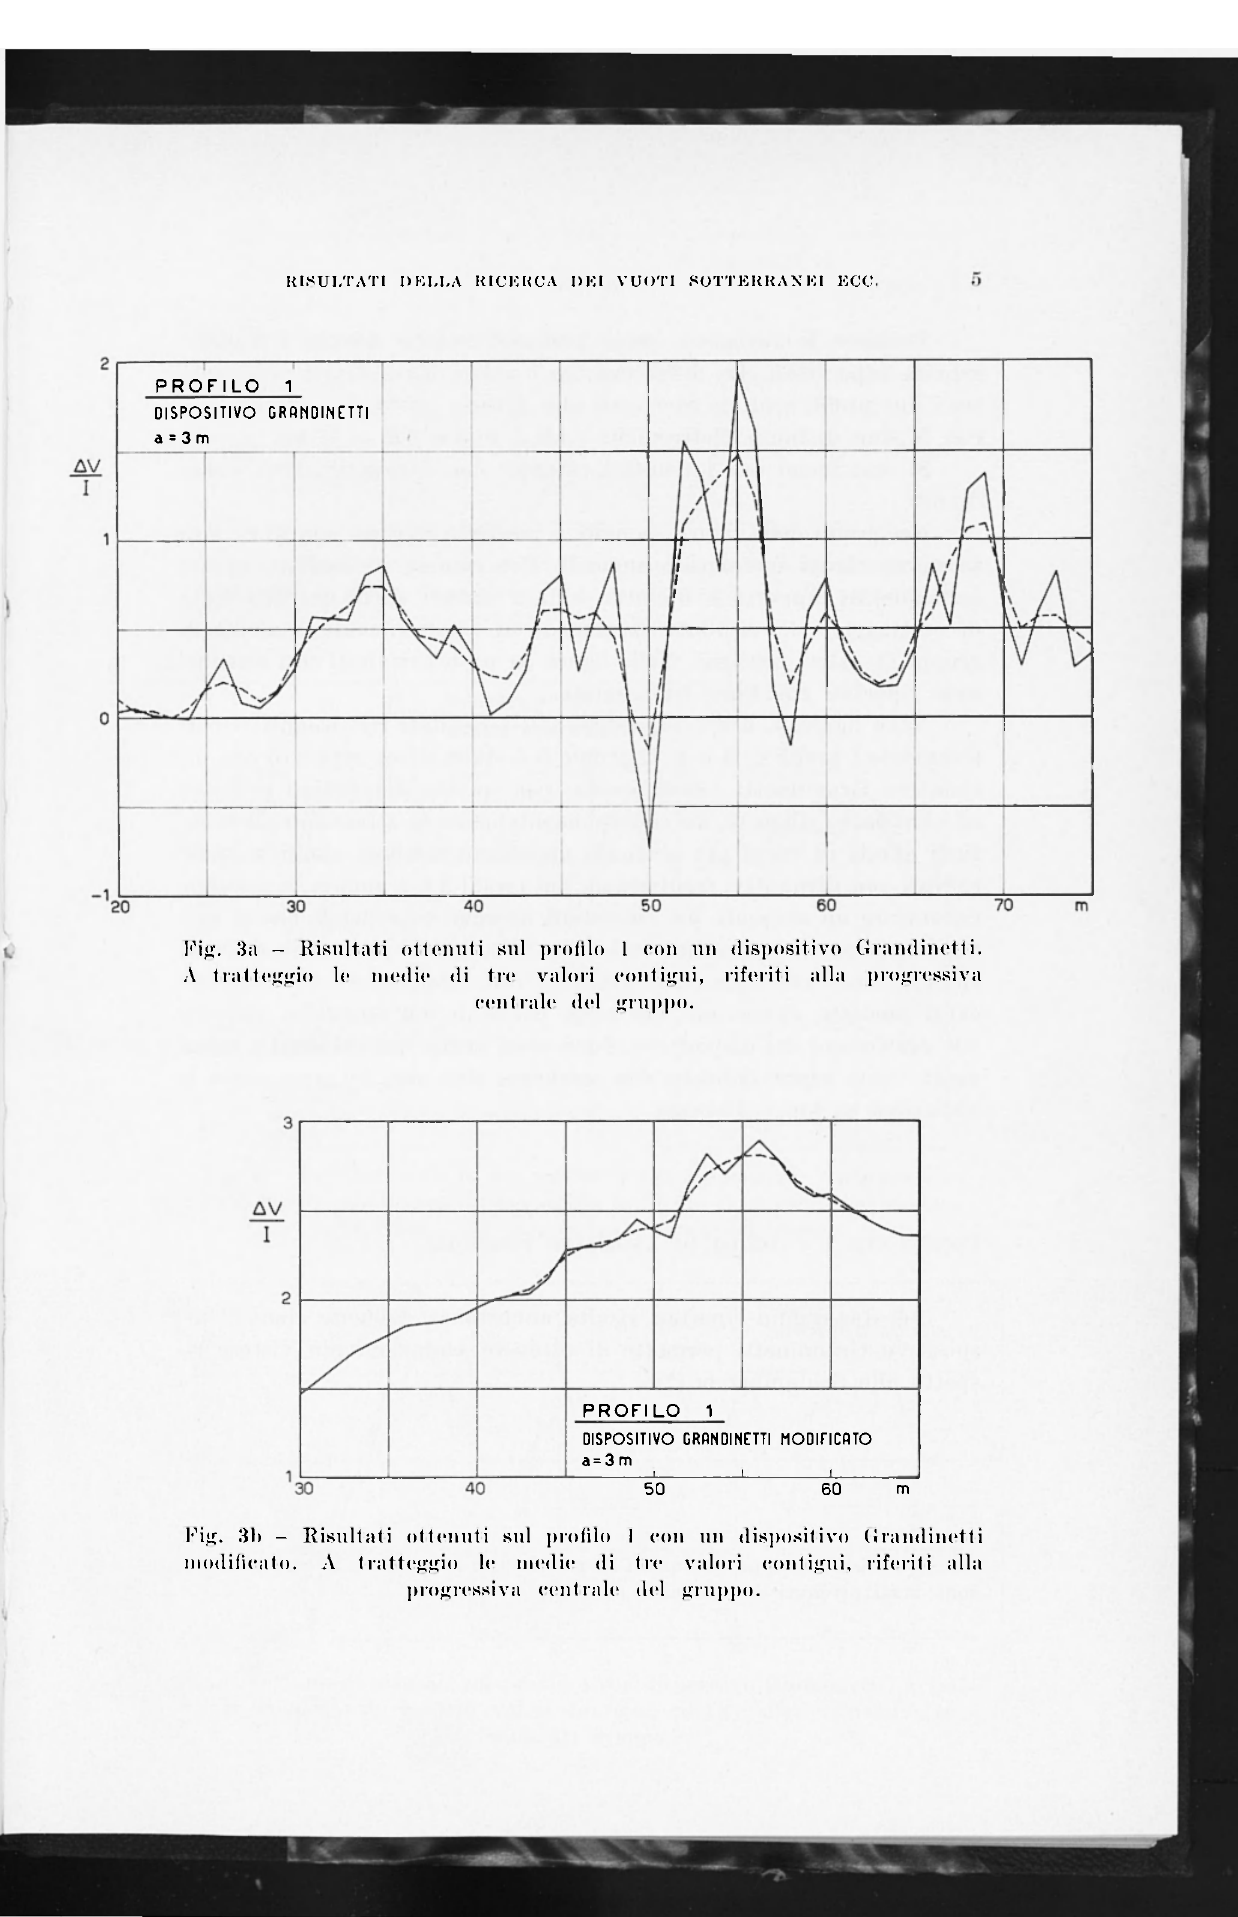
Fig. 3I> Risultati ottenuti sul profilo 1 con un dispositivo Grandinetti modificato. A tratteggio le medie di tre valori contigui, riferiti alla progressiva centrale del gruppo.